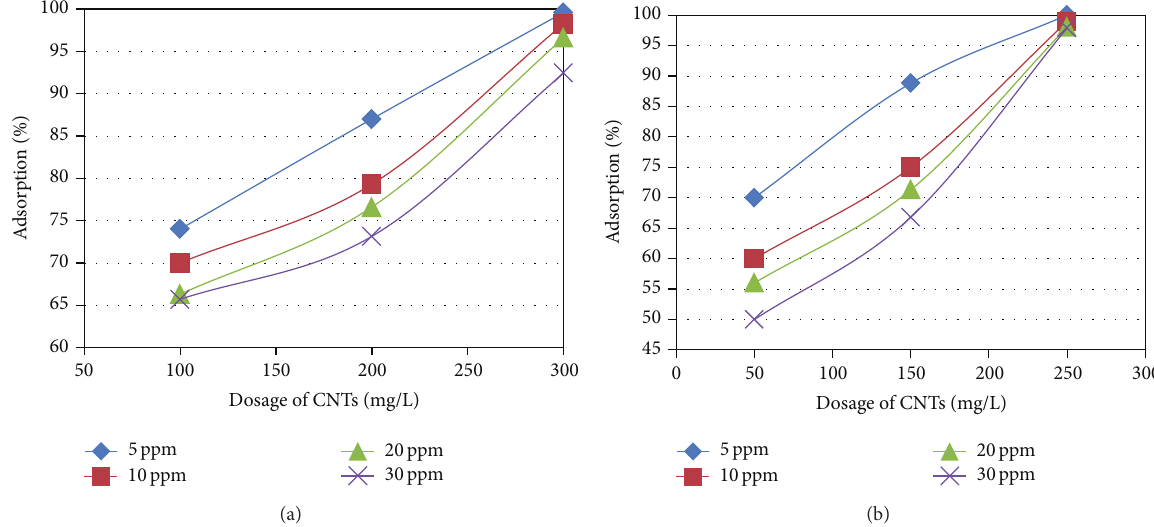
Figure 10: (a) Effect of CNTs dosage on basic orange dye adsorbed % (contact time = 30 min, pH = 8.5). (b) Effect of CNTs dosage on methyl violet dye adsorbed % (contact time = 40min, pH =